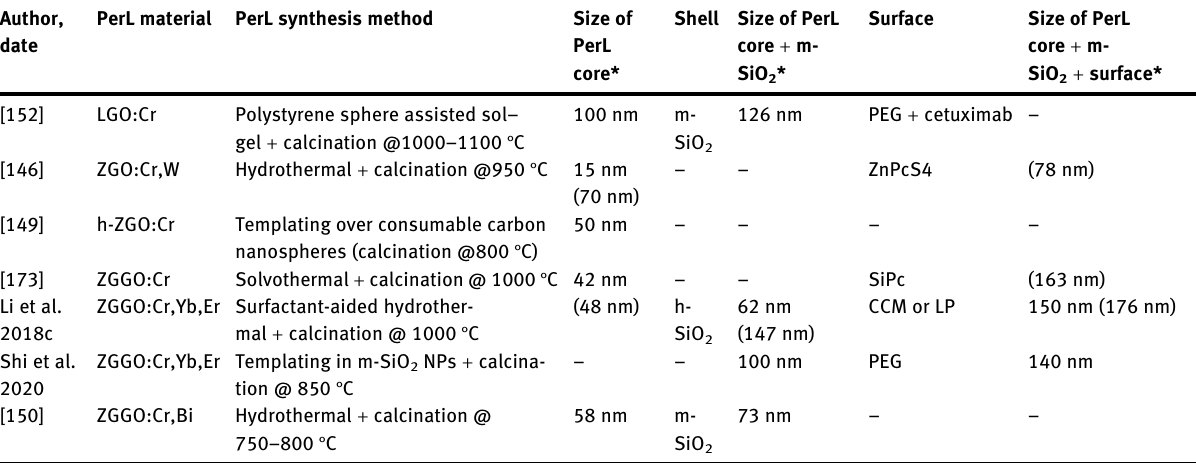
Table  : Sizes of nanoparticles systems for in vivo PerL-mediated PDT. *Size according to TEM (hydrodynamic size according to